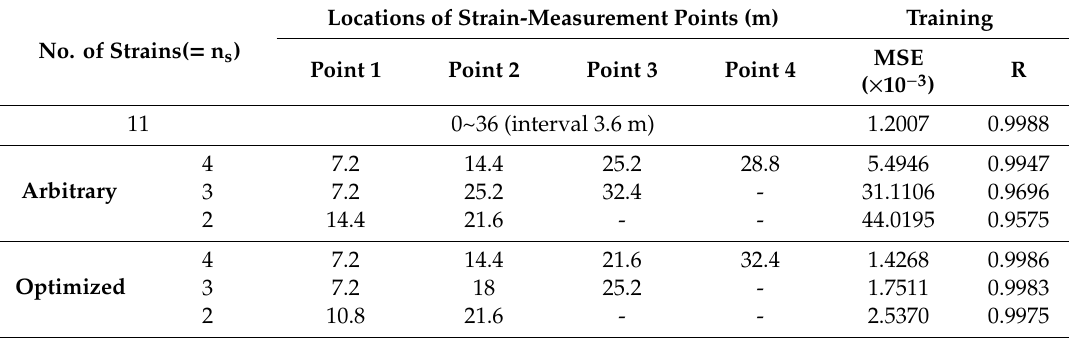
Table 6. The results of ANN training with optimized strain-measurement